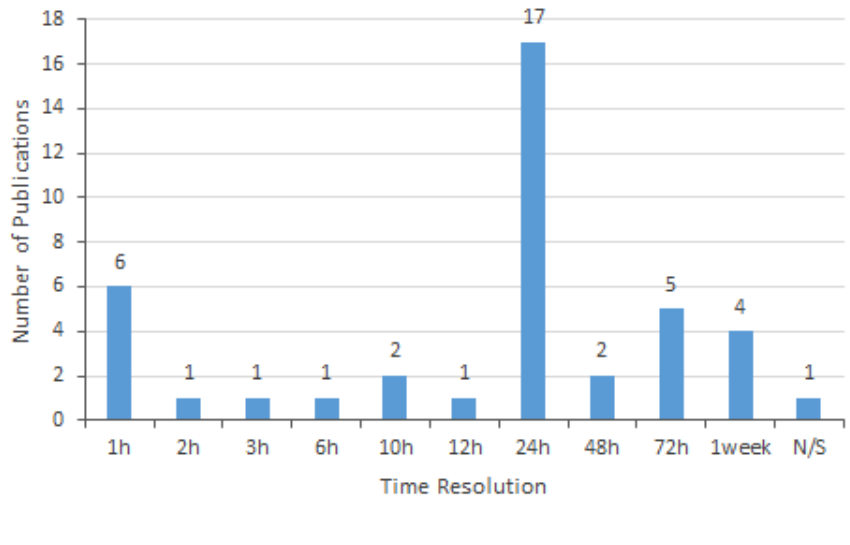
Figure 10. Time granularity.